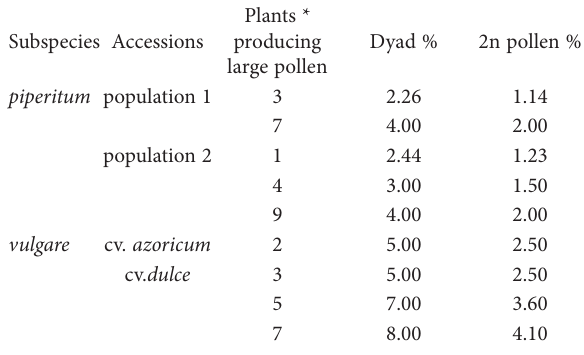
Table 2. Frequencies of dyads and 2 n pollen recorded in plants of of subspp. piperitum and vulgare producing large pollen .